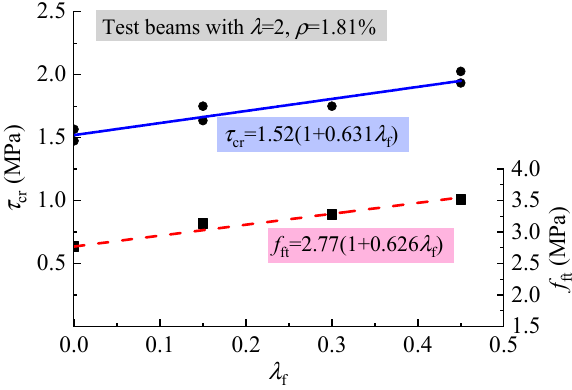
Figure 7. Variations of τ cr and f ft with λ f .